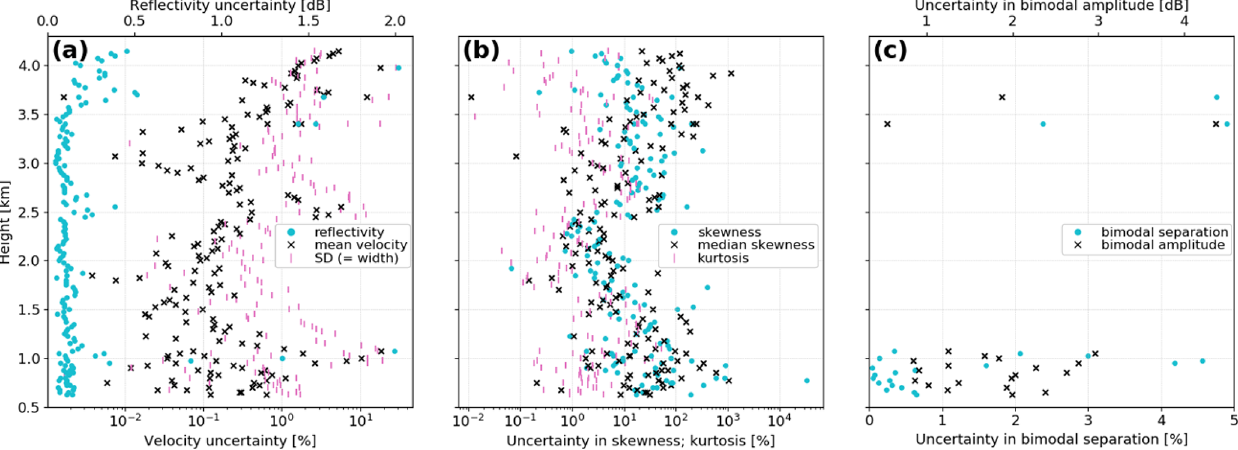
Figure 7. Uncertainty estimates for all data shown in Fig. 6. Corresponding mean and median values are listed in Table